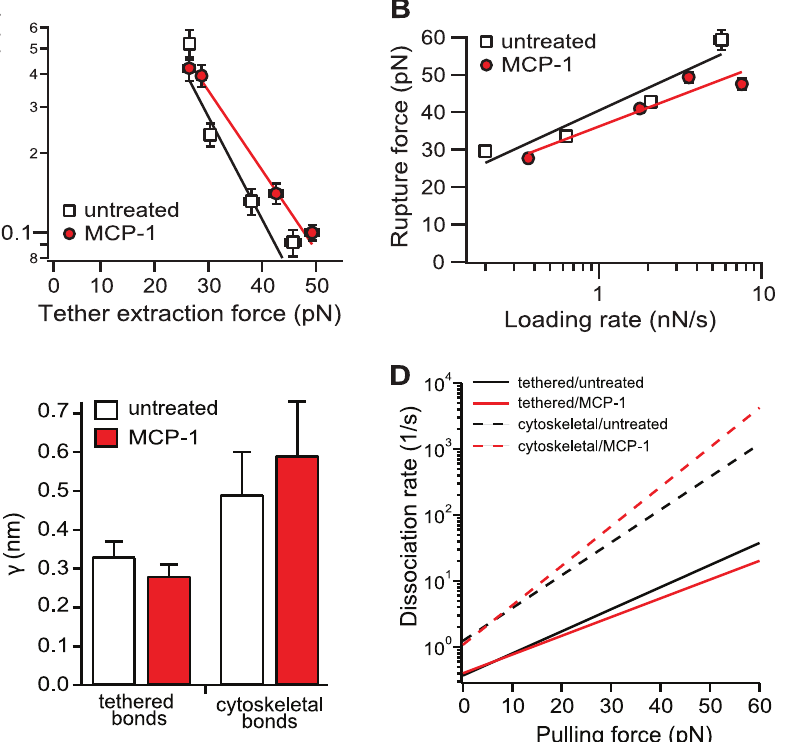
Figure 4. Effects of MCP-1 on single molecule membrane-tethered and cytoskeleton-anchored a 4 b 1 /VCAM-1 bonds. (A) Bond lifetime versus tether extraction force of untreated (squares) and MCP-1-stimulated (circles) a 4 b 1 /VCAM-1 single tethered ruptures. Force spectra of single tethered a 4 b 1 /VCAM-1 bonds were fitted with the Bell model. Error bars denote 6 1 standard error of the median tether force (horizontal) or 6 1 s.e.m of the mean tether lifetimes (vertical). (B) Force spectra (rupture force versus loading rate) of untreated (squares) and MCP-1-stimulated (circles) single cytoskeleton a 4 b 1 /VCAM-1 anchored bonds. Data were fitted with the Bell-Evans model. (C) Plot of energy barrier width parameters for membrane- tethered and cytoskeleton-anchored a 4 b 1 /VCAM-1 complexes. (D) Kinetic profiles of untreated and MCP-1 stimulated cells. The force dependent dissociation rate of the complex is given by k ( f ) ~ k 0 exp f c = k B T ½ (cid:2) , where k u and c the Bell model parameters tabulated in Table 1. Single molecule measurements were conducted on a total of 27 cells for untreated condition, and a total of 24 MCP-1 treated cells. All of the data points in A and B were within their respective 95% confidence bands of the fits.